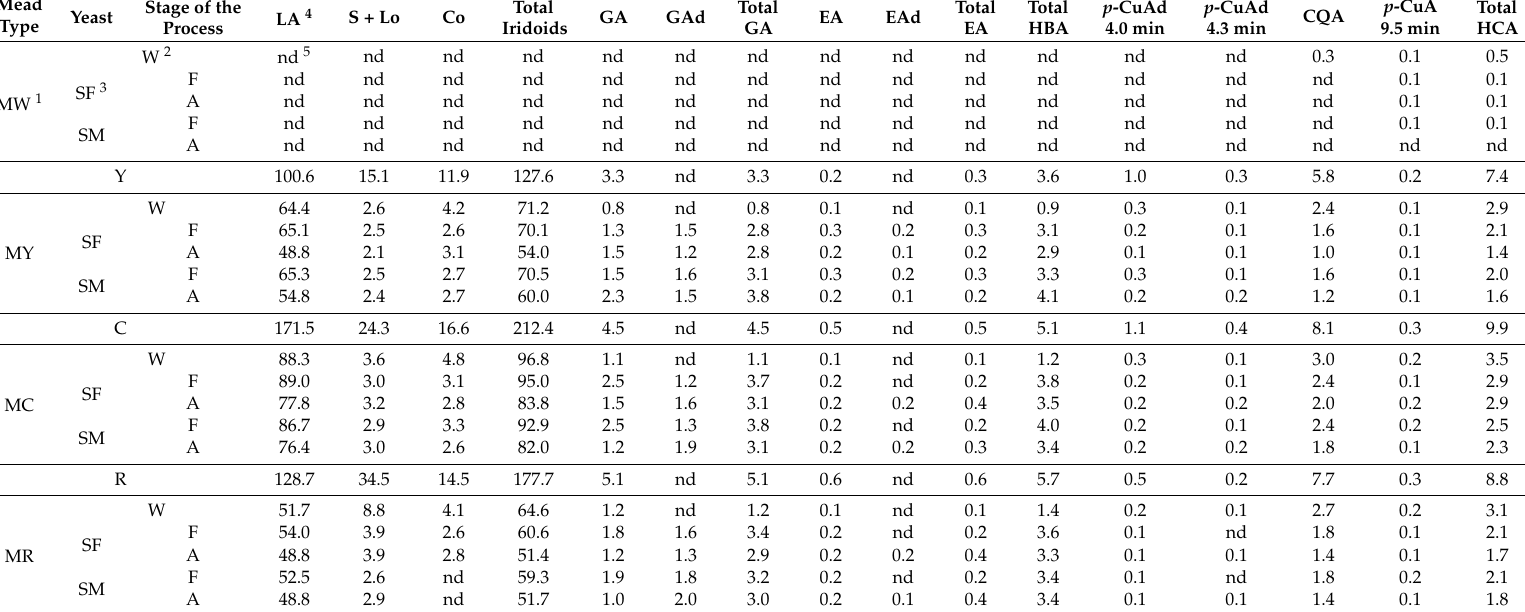
Table 3. Iridoids and phenolic acids content (mg/L) in mead samples (MW, MY, MC, MR) at different stages of their production: worts (W), samples after alcoholic fermentation (F), and meads after aging (A), fermented with different yeast: S. bayanus Safspirit Fruit (SF), S. cerevisiae Safspirit Malt